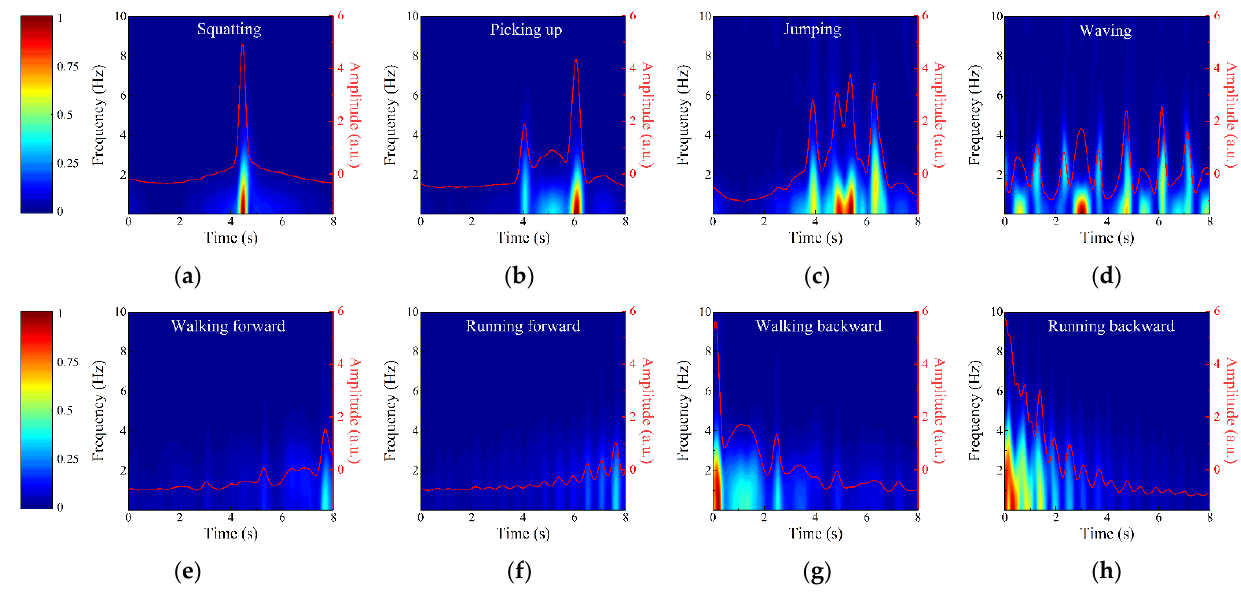
Figure 9. TF diagrams and the corresponding first principal components of ( a ) squatting, ( b ) picking up, ( c ) jumping, ( d ) waving, ( e ) walking forward, ( f ) running forward, ( g ) walking backward, and ( h ) running backward.